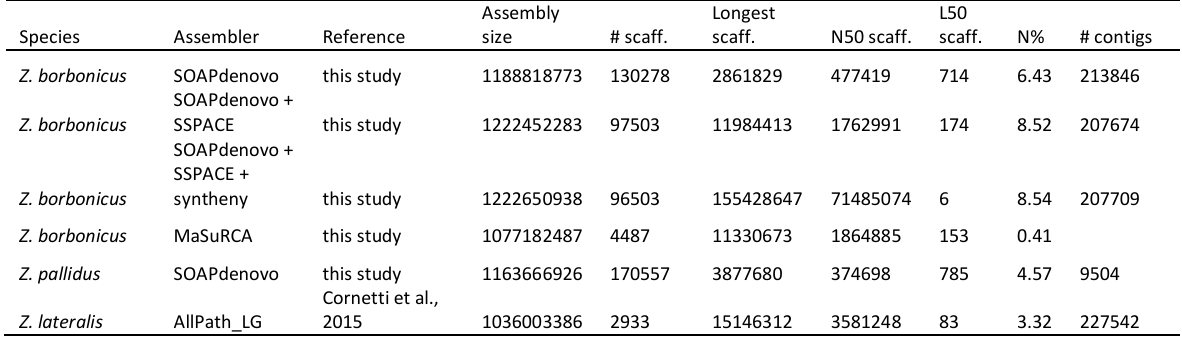
Table S1. Summary statistics of the Zosterops genome assemblies as computed by Assemblathon2. Values in bold correspond to the summary statistics of the publicly available